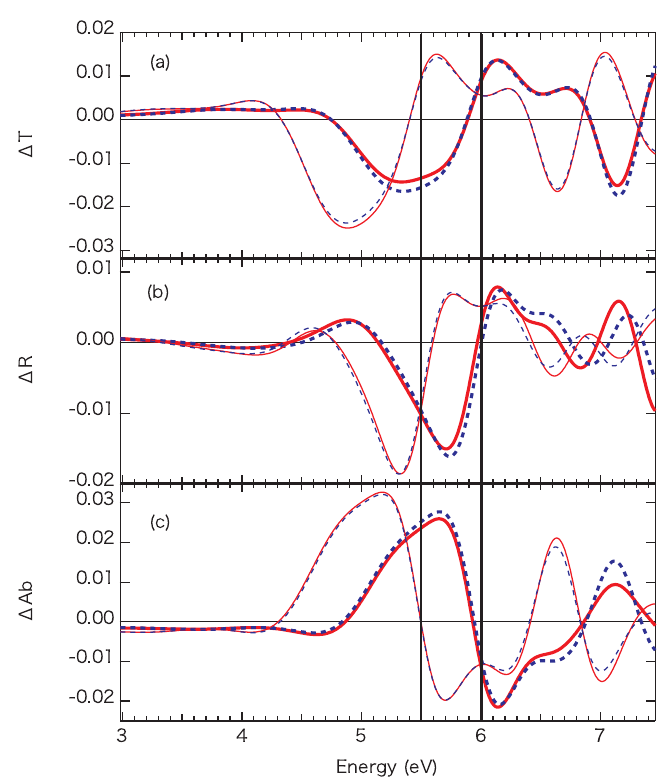
Figure 5. Exchange-correlation potential dependence on Tr-DFKE for ( a ) ∆ T , ( b ) ∆ R , and ( c ) ∆ Ab . The pump-probe time-delay is same as Figure 1. Thick solid lines represent the mBJ potential and thin solid lines represent the LDA potential. Dashed lines represent the independent particle model. The vertical thick (thin) solid lines indicate the calculated optical band gap by mBJ (LDA)